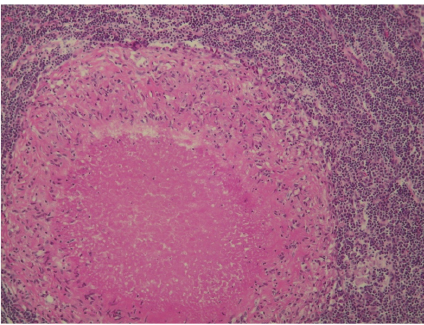
Figure 3: Surgical pathology revealing intense active inflammation with the presence of necrotizing